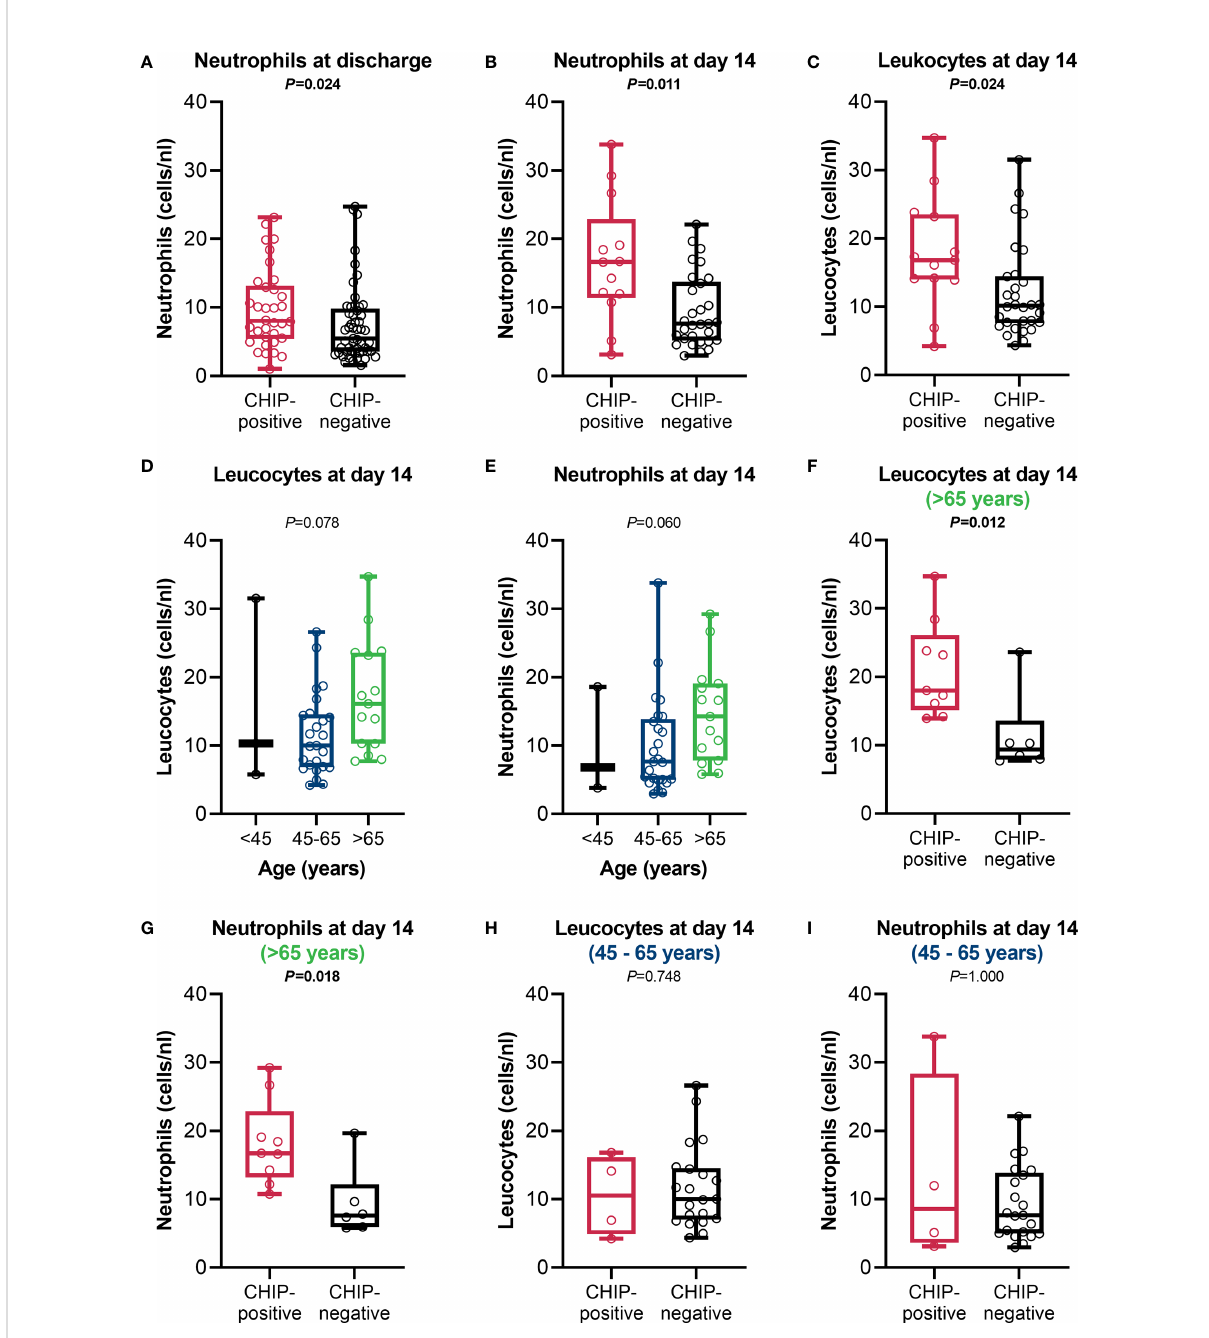
FIGURE 5 Leucocyte and neutrophil counts. Neutrophil counts at (A) discharge (CHIP-positive: n=34; CHIP-negative: n=53), (B) day 14 after admission, and (C) leucocyte counts at day 14 after admission (CHIP-positive: n=13; CHIP-negative: n=30). (D) Leucocyte and (E) neutrophil counts in comparison between the different age groups at day 14 after admission (<45: n=3; 45-65: n=25; >65: n=15). (F) Leucocyte and (G) neutrophil counts for patients aged >65 years (CHIP-positive: n=9; CHIP-negative: n=6) and (H, I) 45 – 65 years (CHIP-positive: n=4; CHIP-negative: n=21) at day 14 after admission. Group comparisons were performed by two sided (A – C, F – I) Mann – Whitney U-test or (D, E) Kruskal-Wallis test. Each data point represents an individual patient. Horizontal line within the box marks the median, boxes depict the IQR, and whiskers indicate the total range. Statistically signi fi cant results (P ≤ 0.05) are highlighted by bold